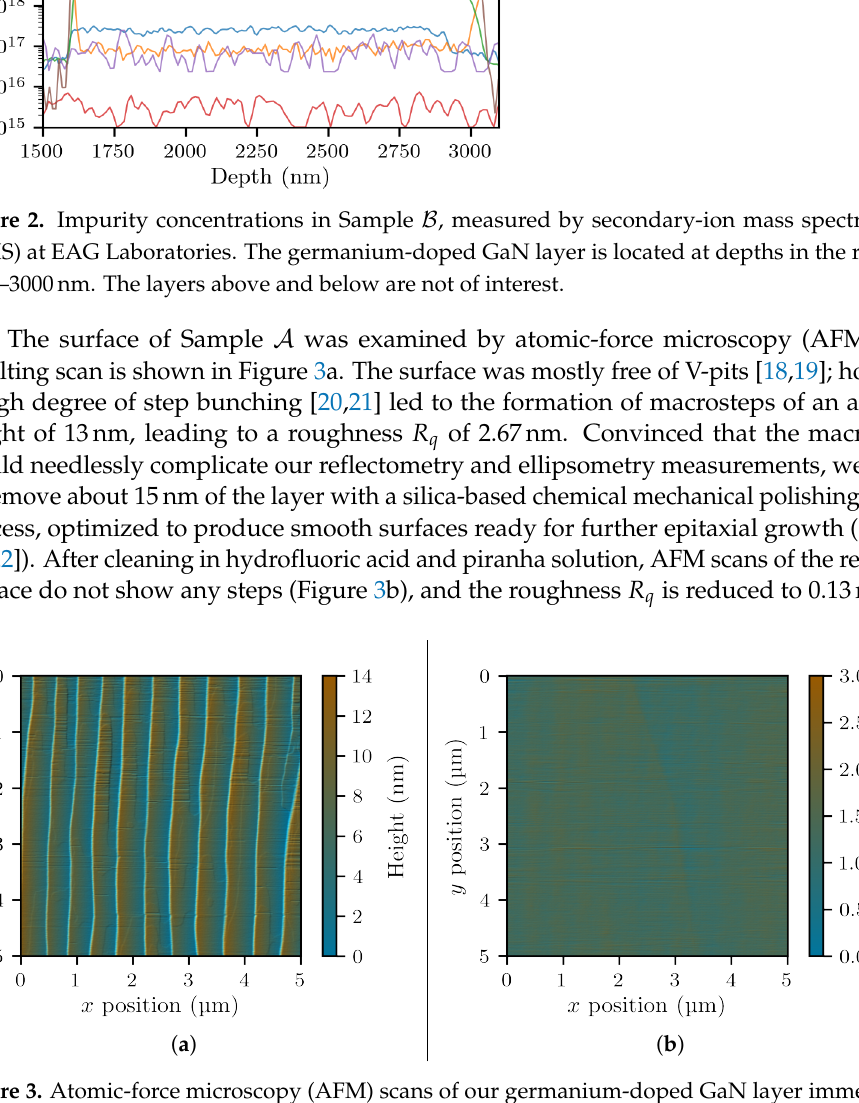
Figure 3. Atomic-force microscopy (AFM) scans of our germanium-doped GaN layer immediately before ( a ) and after ( b ) chemical mechanical polishing